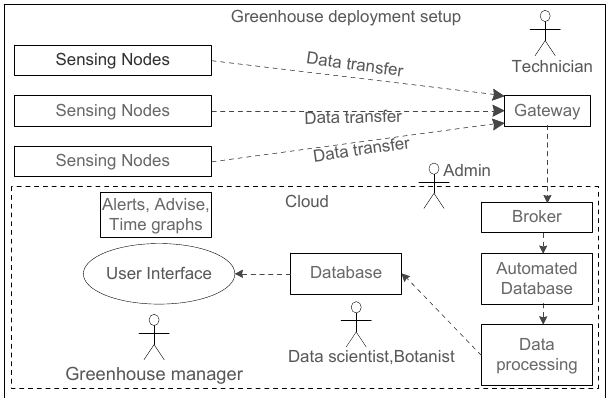
Figure 2. Greenhouse deployment setup.